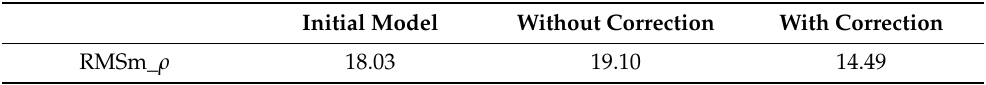
Figure 7. Density slice at x = 4000 m. ( a ) Real model; ( b , c ) inversion result without/with correction.